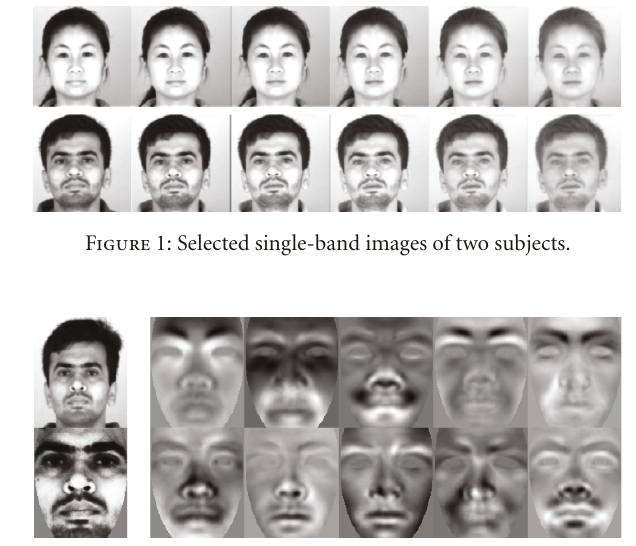
Figure 2: Example of eigenfaces in one